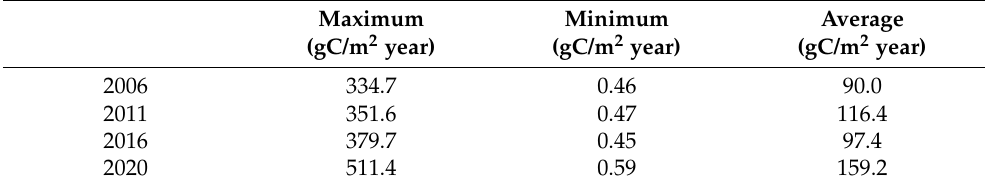
Table 1. The statistical results of the actual NPP in the experimental